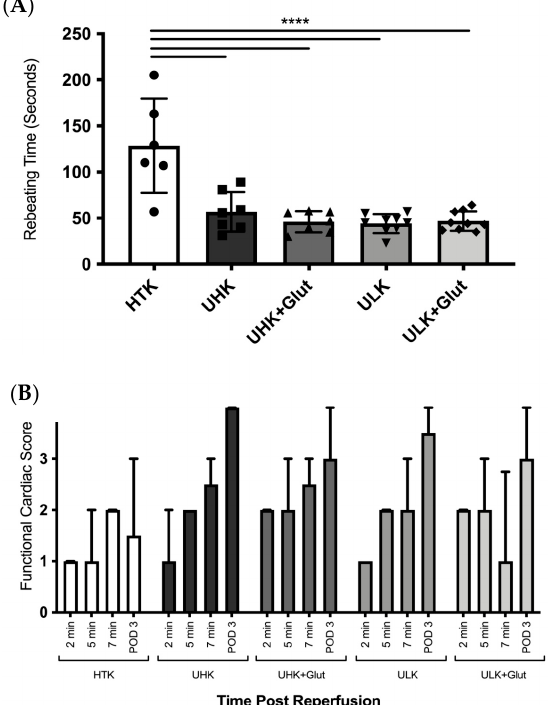
Figure 1. ( A ) Rebeating times, and ( B ) functional assessment after reperfusion. ( A ) Rebeating times were significantly ( p < 0.0001; ANOVA with Dunnett’s multiple comparison correction) shorter in all investigated Unisol-based solutions compared to HTK. ( B ) Functional cardiac score at two, five, and seven minutes and on POD three after reperfusion. Unisol, gluconate-lactobionate-dextran; HTK, histidine-tryptophan ketoglutarate solution; UHK, Unisol-high-potassium; ULK, Unisol-low-potassium; Glut, glutathione; min, minutes; POD, postoperative day. **** p < 0.0001. Table 4. Rebeating times (seconds) after graft flush and storage with HTK and Unisol-based perfusates.